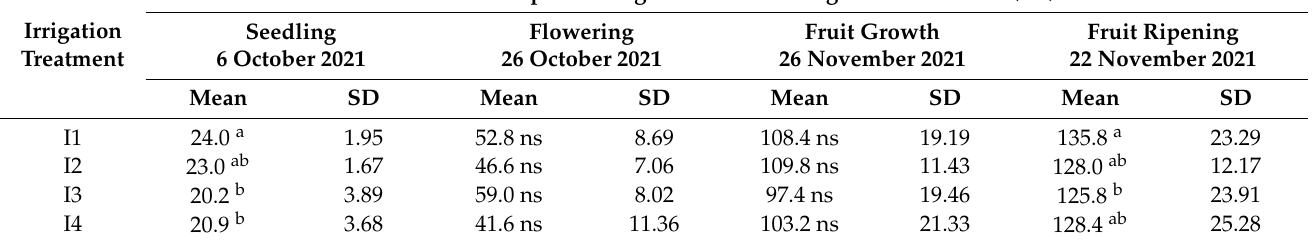
Table 3. Tomato pant height during the seedling, flowering, fruit growth and ripening growth stages under different irrigation conditions (I1, I2, I3 and I4). Data in columns with the same letters are